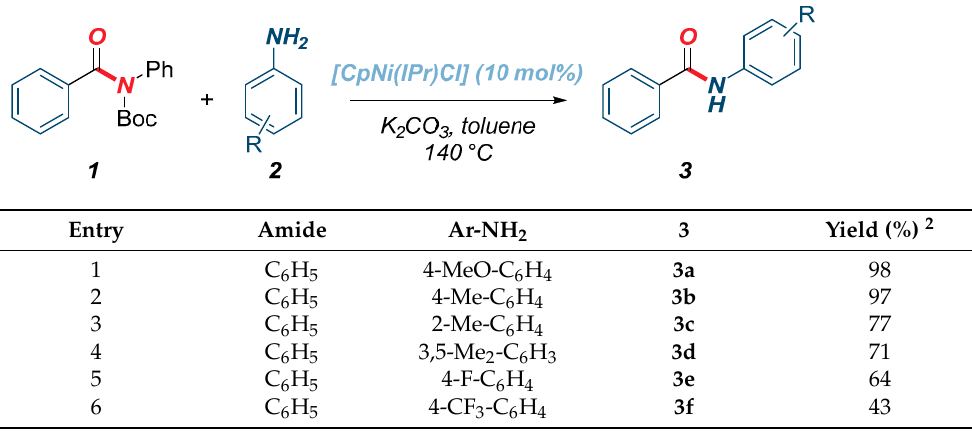
Table 3. Scope of amides in transamidation with aniline 2a using [CpNi(IPr)Cl]. 1